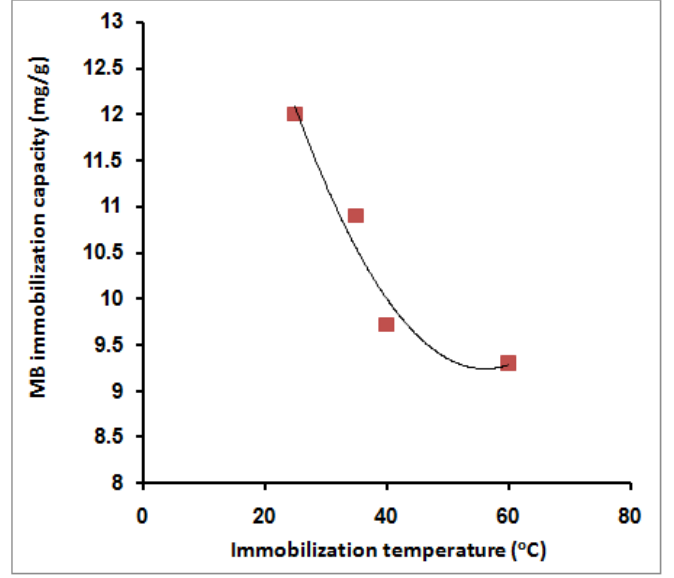
Figure 9. Effect of MB immobilization temperature on its immobilization capacity; 10 mL MB, 40 ppm, 0.02 g SPGMA, 5 min, rpm 200, and 6.5 pH.